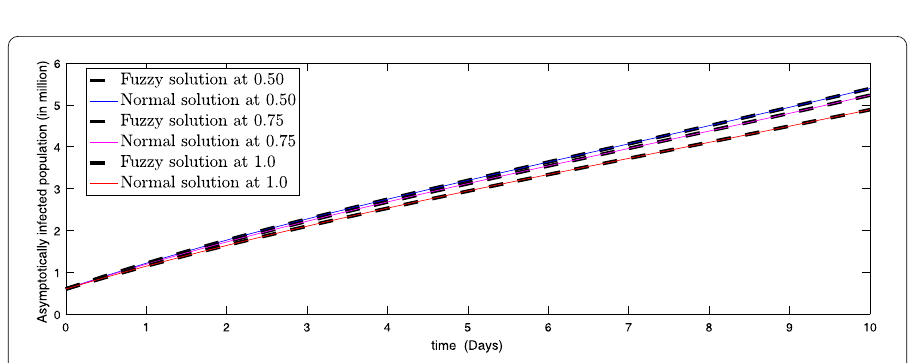
Figure 5 Comparison of approximate fuzzy and normal solution for asymptotically infected compartment for three terms at the given uncertainty values α ∈ [0,1] against various fractional order